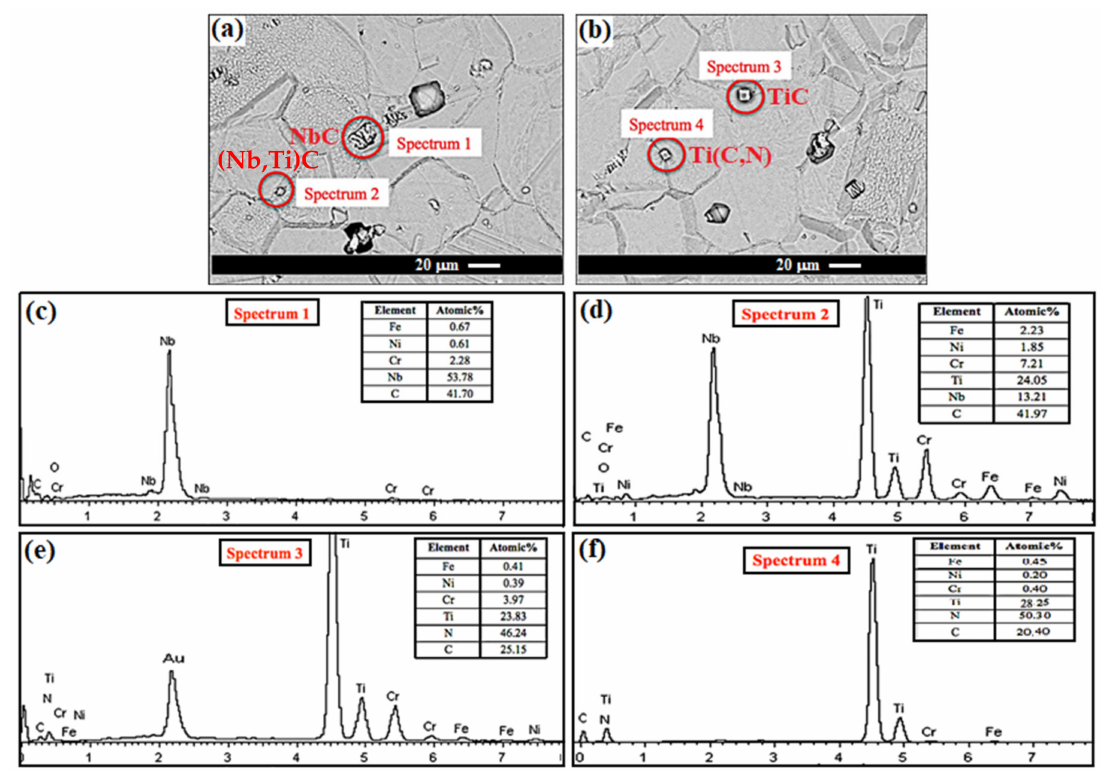
Figure 2. ( a , b ) FESEM images of as-received Fe-40Ni-24Cr alloy and ( c – f ) EDX spectrum of as-received Fe-40Ni-24Cr